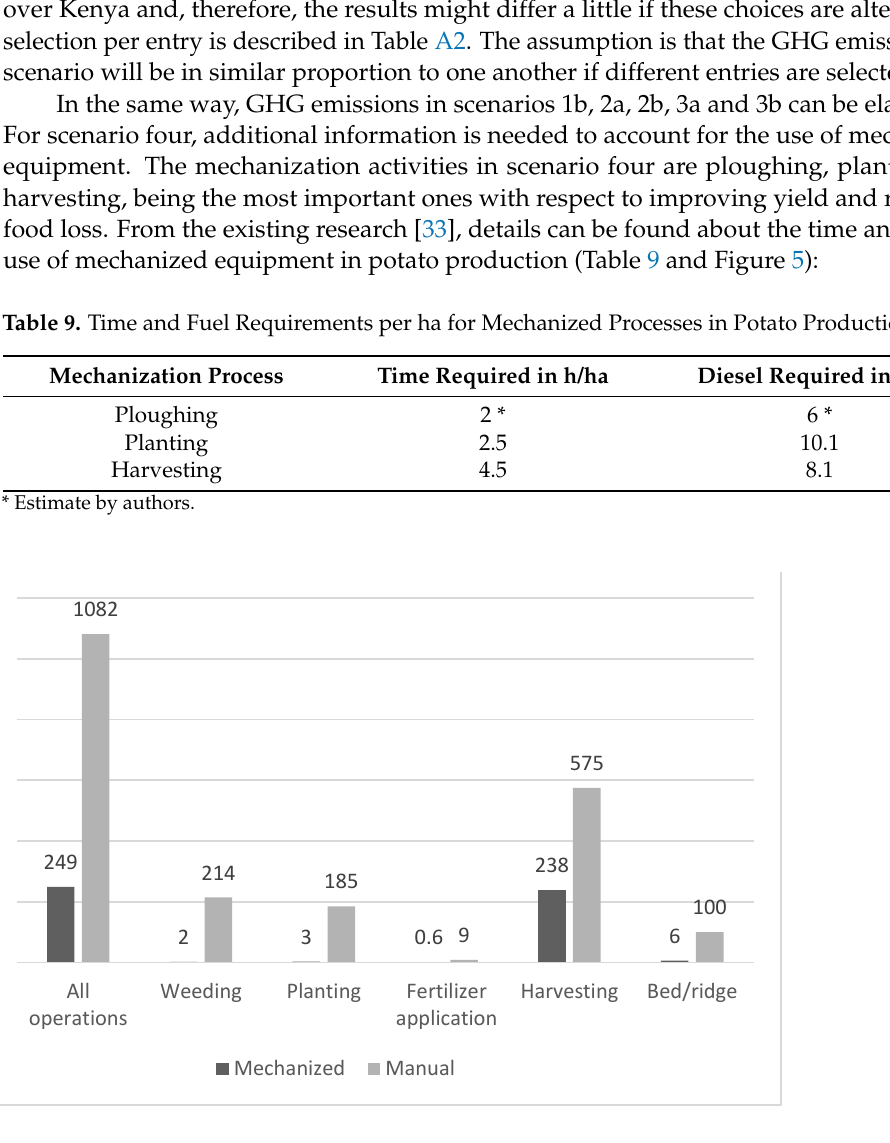
Figure 5. Time Spent in Manhours per ha on Different Activities during Potato Production in Kenya